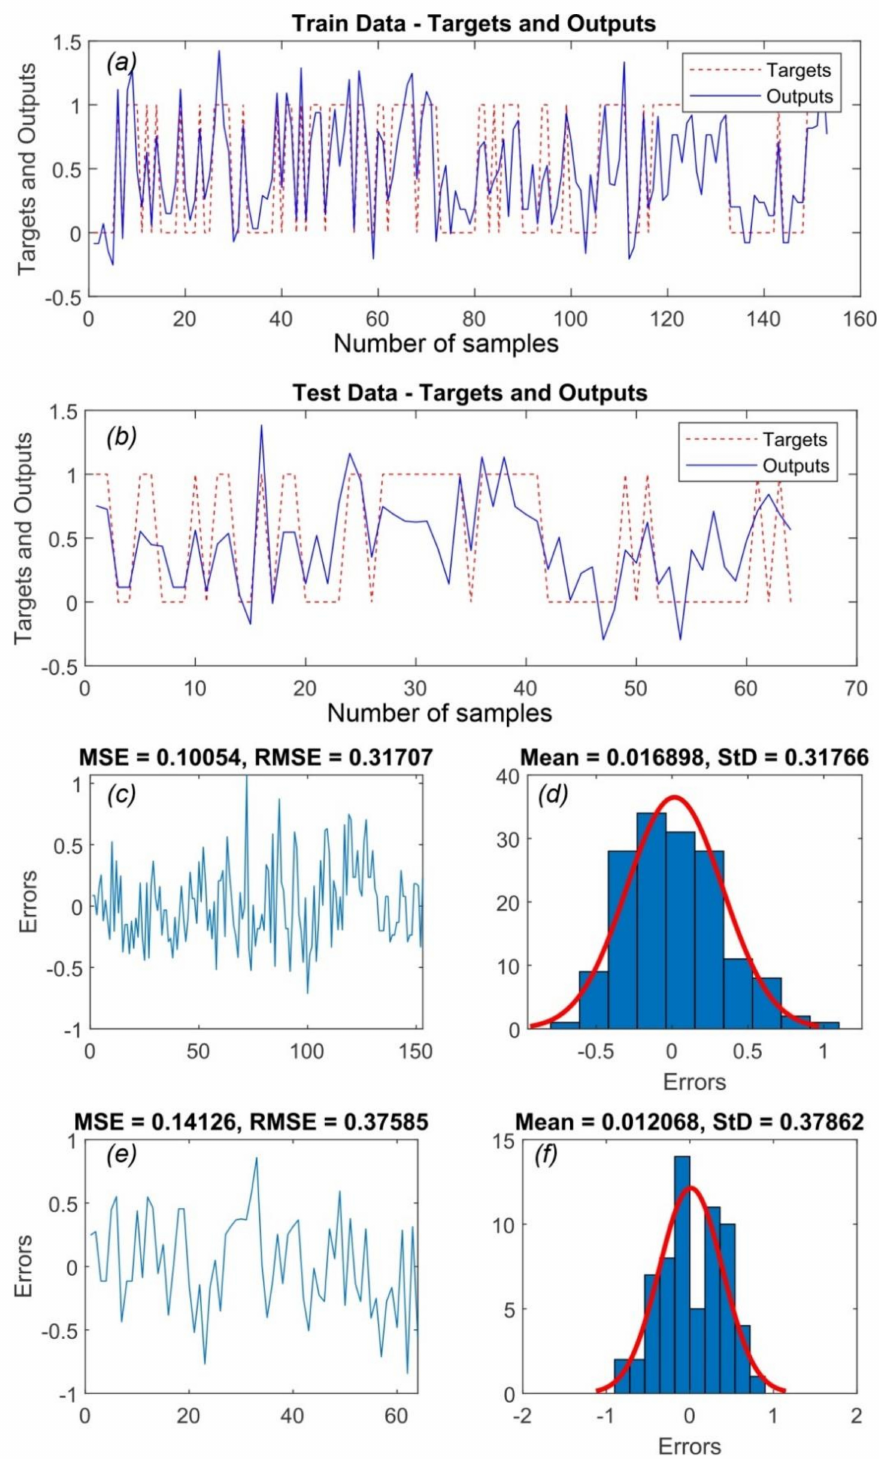
Figure 5. ( a ) Target value and output of ANFIS-WOA model for training data, ( b ) target value and output of ANFIS-WOA model for test data, ( c ) MSE and RMSE values of training samples, ( d ) frequency errors of training samples, ( e ) MSE and RMSE value of test samples, and ( f ) frequency errors of test